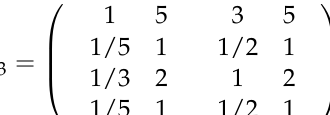
Table 6. Best service placement in the second scenario, power is prioritized over other criteria. Fog1 Fog2 Fog3 Fog4 Process2, Process3, Sense1, Sense2, Process5 Services Process4, Activate1, Process1 Sense3, Process7, Process6 Activate3